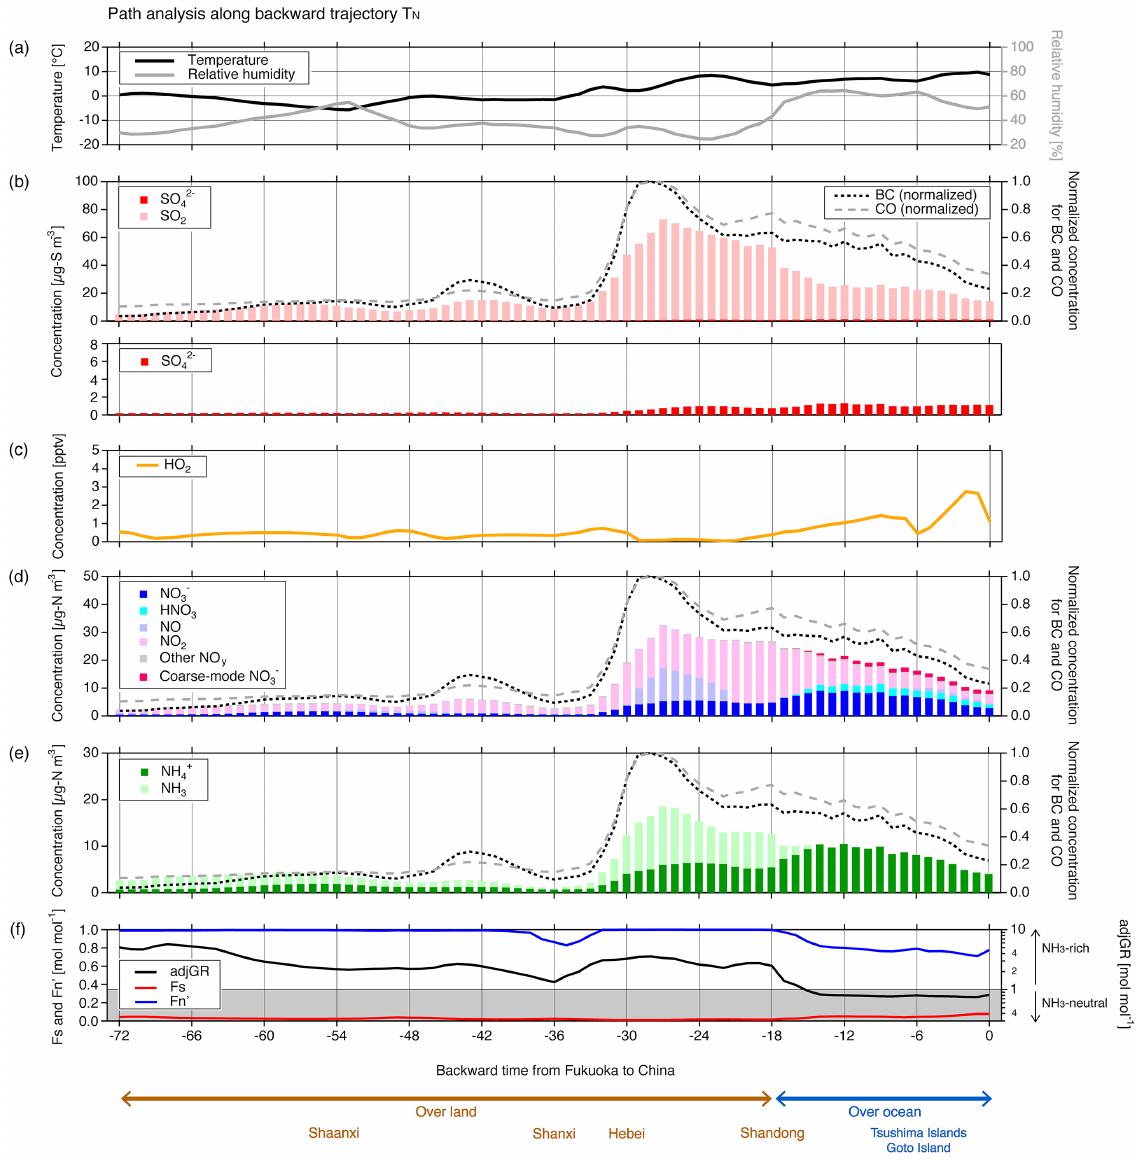
(with expansion at 4